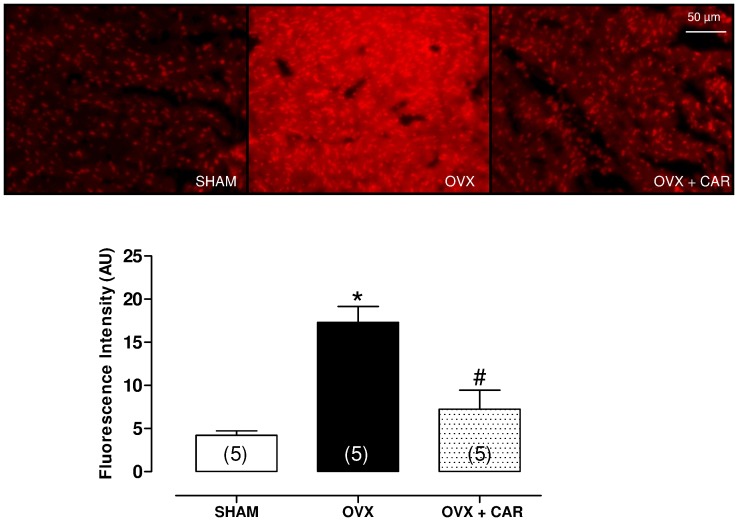
Superoxide anion production in papillary muscle of SHAM, Ovariectomized (OVX), Ovariectomized plus carvedilol (OVX+CAR) at 60 days postsurgery.The values are expressed as the means ± S.E.M. * Significantly different from SHAM and # from OVX (p<0.05) using one-way ANOVA and Tukey post hoc test.